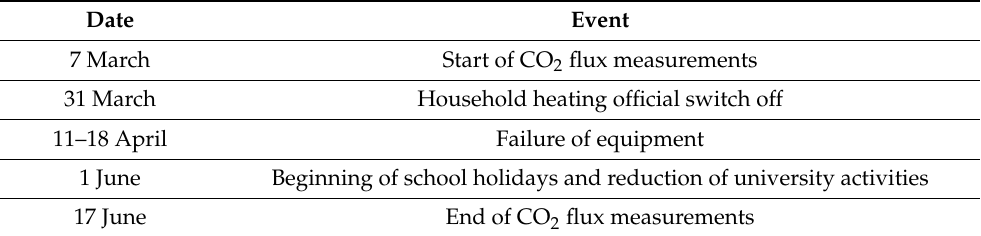
Table 1. Main events during the experimental